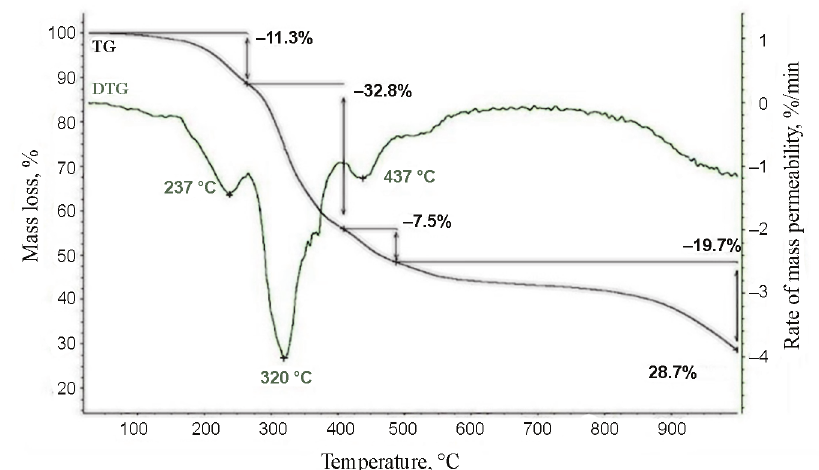
Figure 4. TG, DTG curves fire intumescent paint ATM under